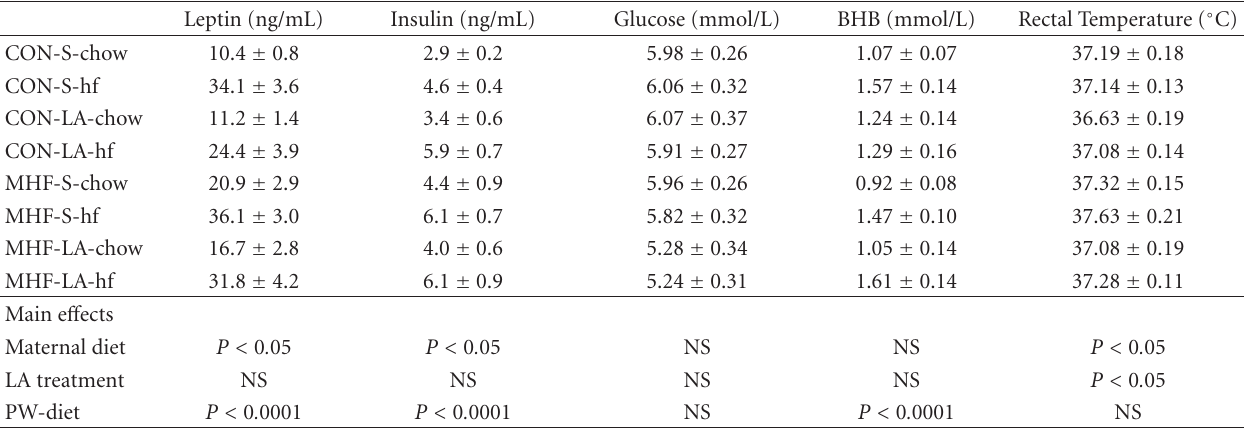
Table 2: Fasting plasma leptin, insulin, glucose, and β -hydroxybutyrate (BHB) measurements and rectal temperature in CON and MHF o ff spring treated with either saline (S) or pegylated leptin antagonist (LA) as neonates and fed either a chow or hf diet after weaning. Data are means ± SEM, n = 8–16 per group, no significant statistical